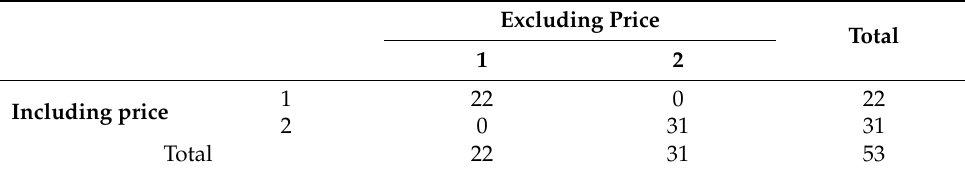
Table 10. Classification comparison for 2 clusters.